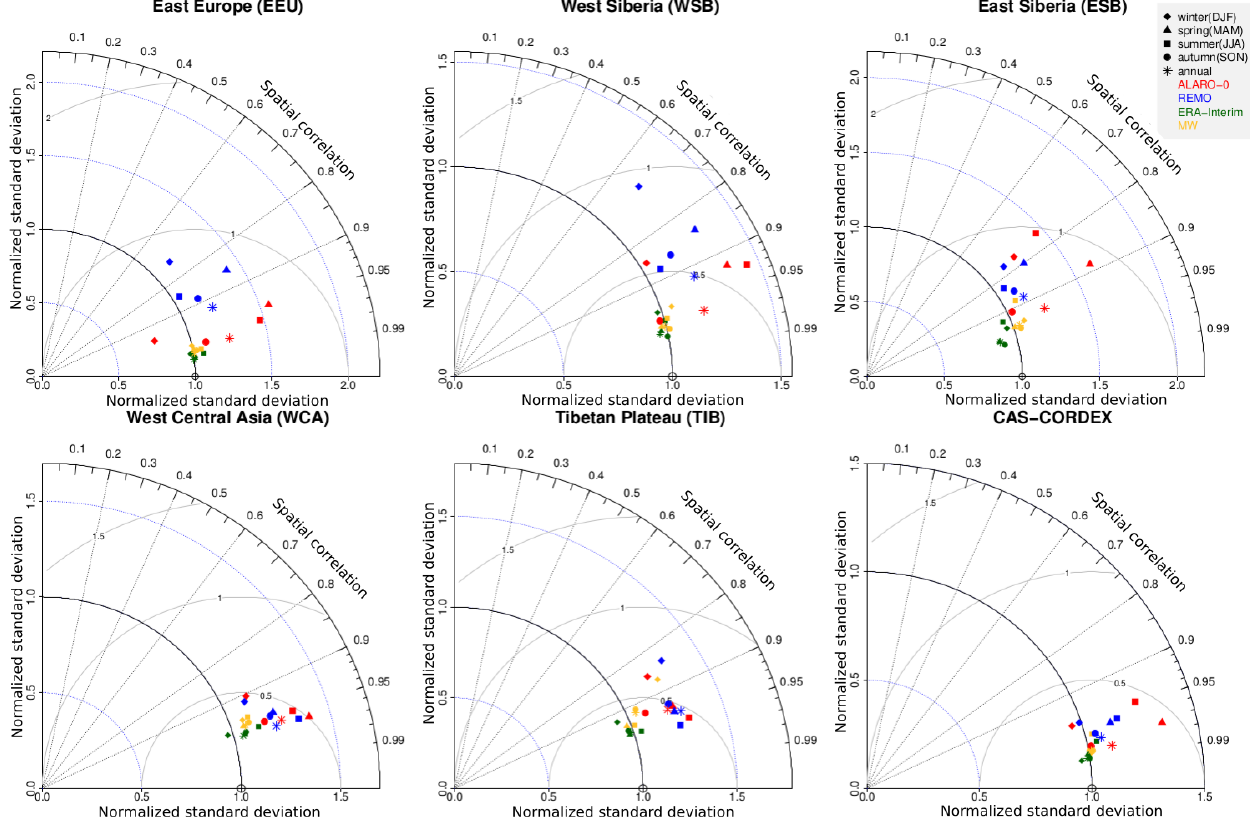
Figure 4. Normalized Taylor diagram showing the spatial performance of mean temperature for seasonal and annual means for both RCMs (ALARO-0 and REMO), the ERA-Interim reanalysis, and MW observational data with respect to CRU for the five subregions and the complete CAS-CORDEX